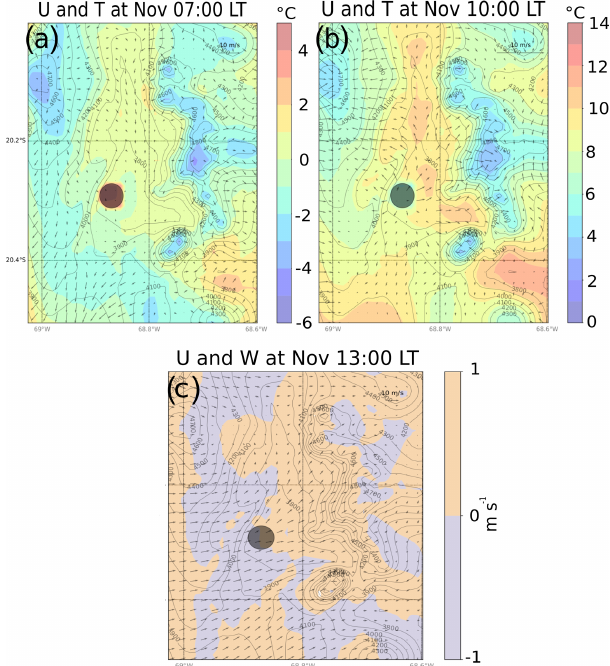
Figure 9. E-DATA period-averaged wind flow WRF simulation of domain D04 at 1km resolution. (a) Surface U and T at 07:00LT. (b) Surface U and T at 10:00LT. (c) U and vertical wind ( W ) at 13:00LT. The black dot represents the saline